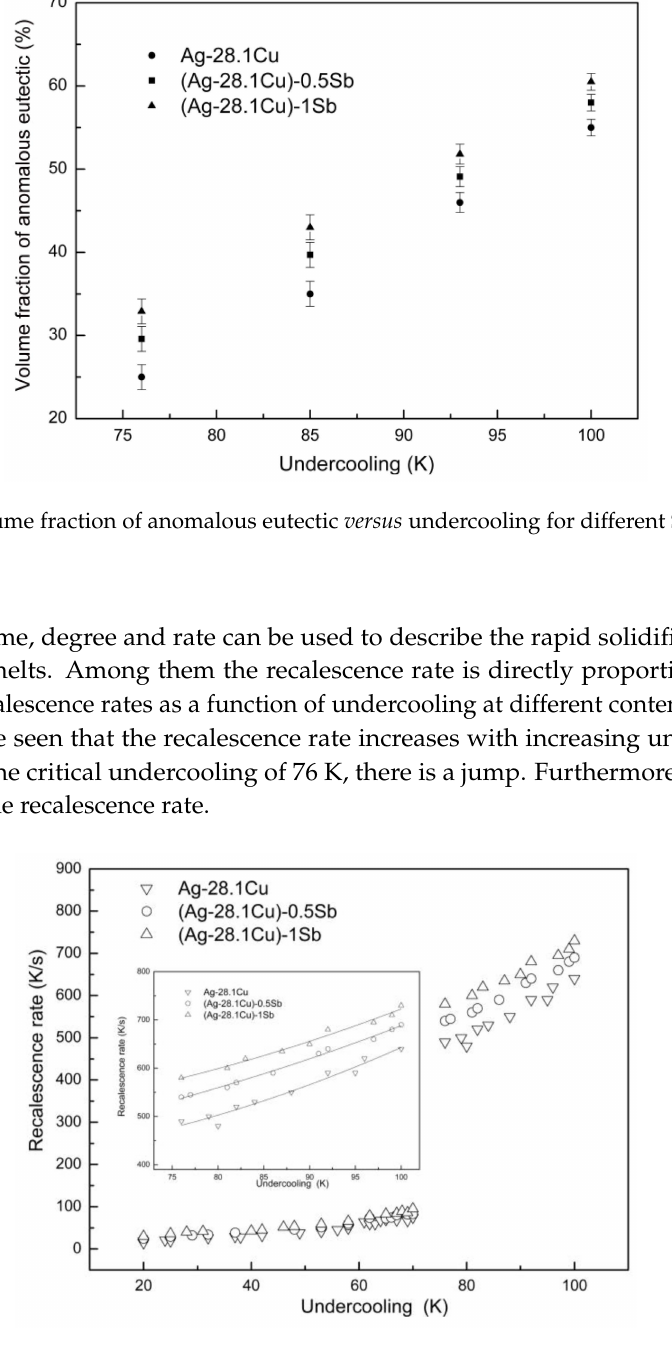
Figure 8. Recalescence rate versus undercooling for different Sb contents. The inset is a local